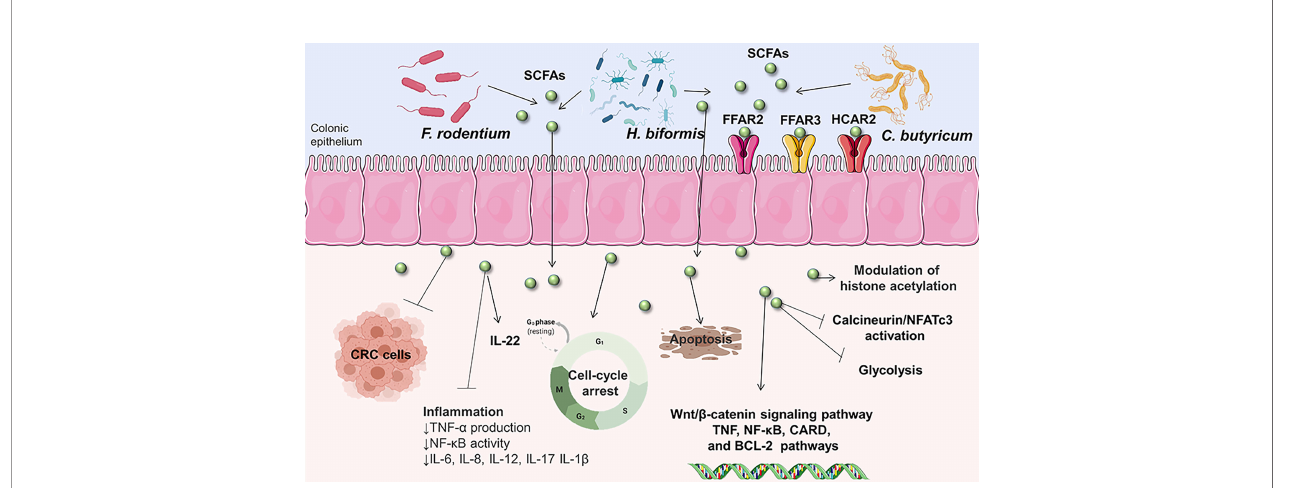
FIGURE 1 | The schematic illustration of different cell processes triggered by SCFAs in CRC cells. Gut microbes catabolize unabsorbed dietary nutrients producing SCFAs. SCFAs can affect the in fl ammatory and immunological responses, colon cancer cell cycle arrest and apoptosis by in fl uencing various receptors, signaling, apoptotic gene expression, which may be linked to the onset and progression of CRC. NFATc3, nuclear factor of activated T cells 3;CARD, proteins containing a caspase-associated recruitment domain; TNF, tumor necrosis factor; NF- k B, nuclear factor kappa-light-chain-enhancer of activated B cells; Bcl-2, B cell lymphoma protein-2; IL-6, interleukin-6; TNF- a , tumor necrosis factor- a ; IL-22, interleukin-22; IL-8, interleukin-8; IL-12, interleukin-12; IL-17, interleukin-17; IL-1 b , interleukin-1 b